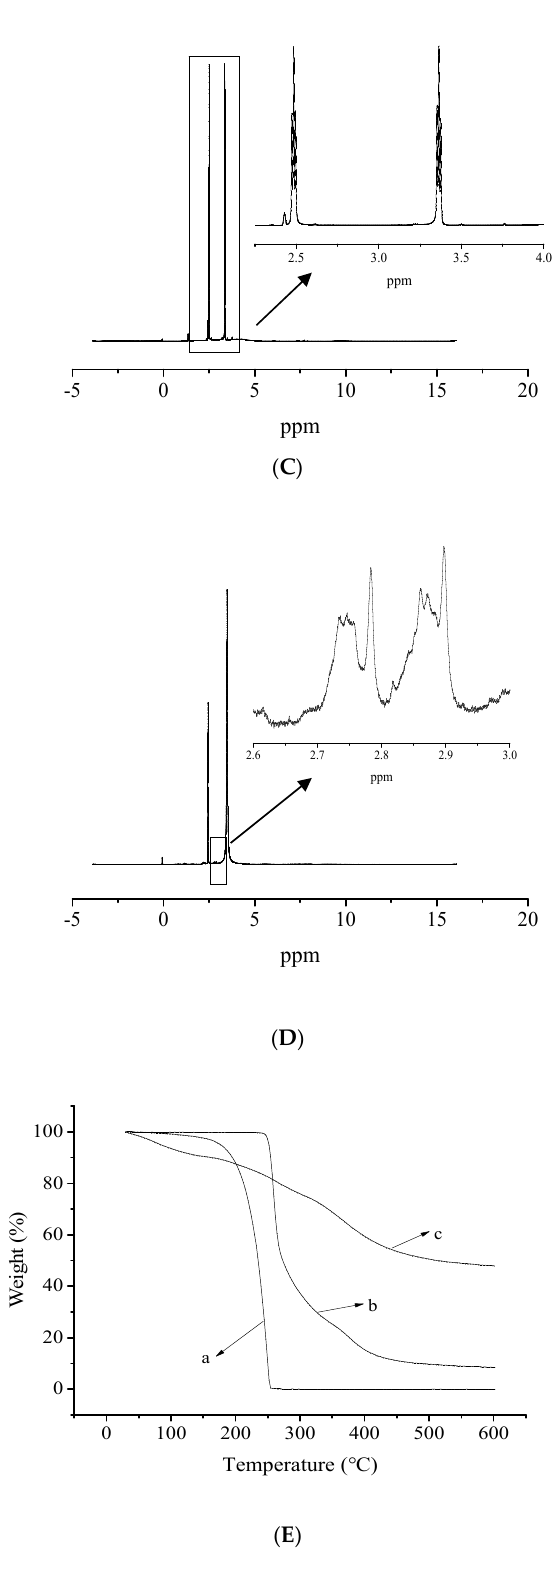
Figure 2. ( A ) The Fourier infrared spectrum (FTIR) spectra of the EDTA (a), DEA (b) and PEDTA-DEA (c). ( B ) 1 H NMR spectra of EDTA in DMSO-d 6 . ( C ) 1 H NMR spectra of DEA in DMSO-d 6 . ( D ) 1 H NMR spectra of PEDTA-DEA in DMSO-d 6 . ( E ) The stability analysis of DEA (a), DETA (b) and PEDTA-DEA